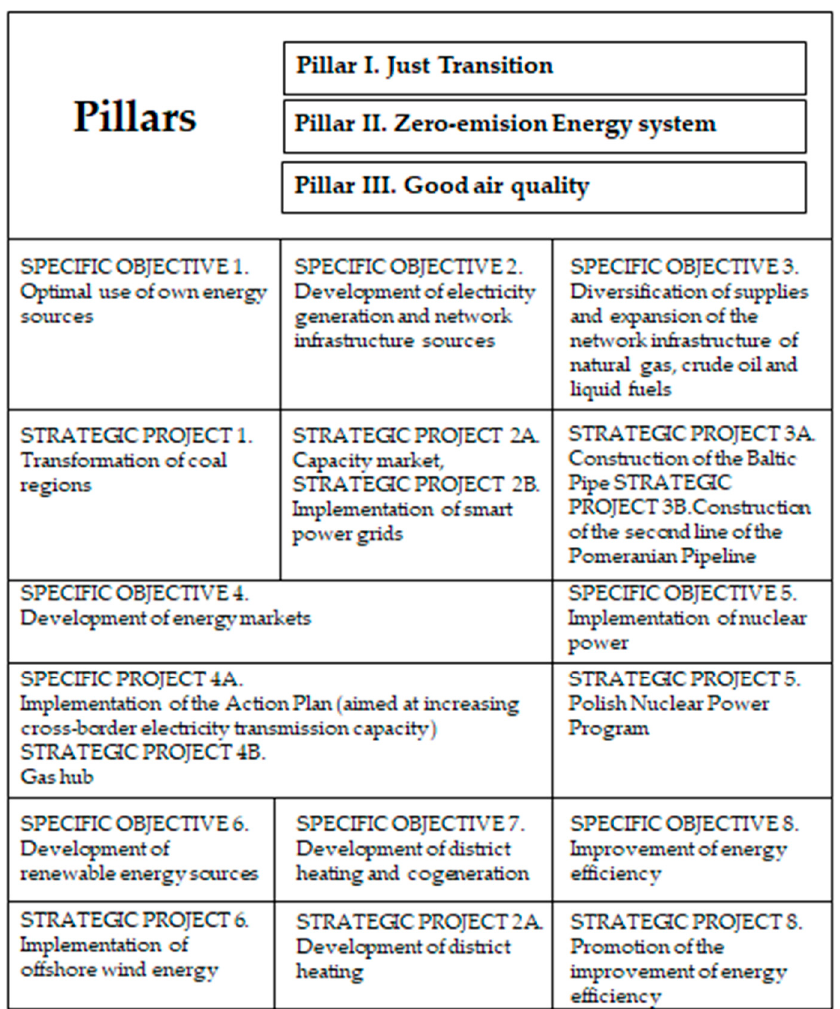
Figure 2. The core of energy policy of Poland until 2040, based on energy policy of Poland until 2040. Source: Energy policy of Poland until 2040.